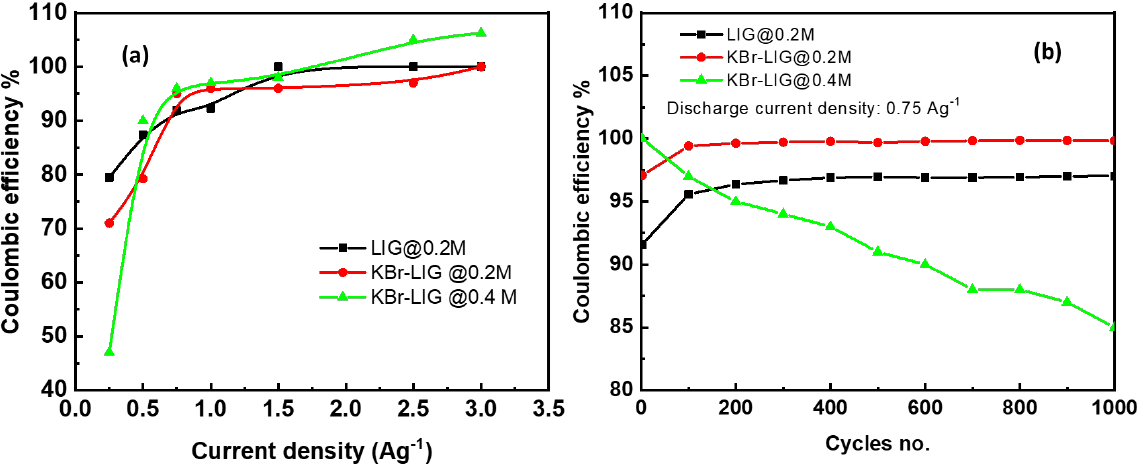
Figure 11. The Coulombic efficiency as a function of ( a ) current density and ( b ) cycles for LIG@0.2M, KBr-LIG@0.2M, and KBr-LIG@0.4M.